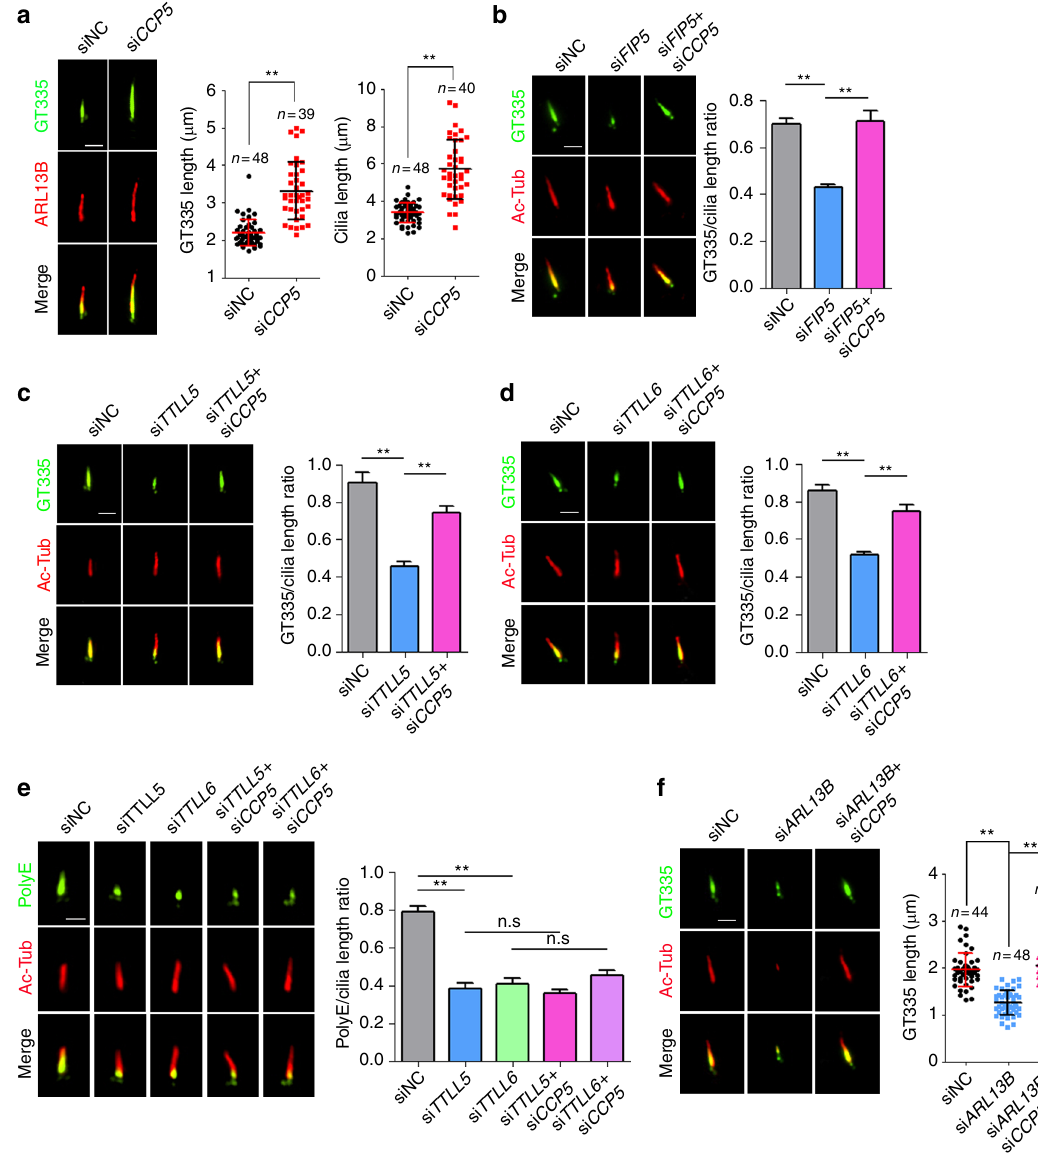
Fig. 4 A balanced enzymatic activity between CCP5 and TTLL5/TTLL6 is critical for maintaining a proper level of axoneme polyglutamylation. Axoneme polyglutamylation was detected by antibody GT335 or polyE. GT335 antibody detects all polyglutamate side chains independently of their length ( ≥ 1 glutamates) while polyE antibody is speci fi c to long side chains ( ≥ 3 glutamates). a Depletion of CCP5 increased axoneme polyglutamylation and cilia length. Quanti fi cation in right panels. b – d Depletion of CCP5 corrected FIP5 - ( b , siNC: n = 54, siFIP5: n = 42, siFIP5 + siCCP5: n = 49 cilia), TTLL5 - ( c , n = 50 cilia for each group), or TTLL6 - ( d , n = 50 cilia for each group) knockdown-induced defective axoneme polyglutamylation as detected by GT335 antibody. Quanti fi cation in right panels. e Depletion of CCP5 could not restore long-chain axoneme glutamylation as detected by polyE antibody. Quanti fi cation in right panel ( n = 50 cilia for each group). f Depletion of CCP5 restored axoneme polyglutamylation in ARL13B-de fi cient cells as detected by GT335 antibody. Quanti fi cation in right panel. Scale bars: 2 μ m. Center values represent mean. Error bars represent s.d. N values: cilia number accessed from at least six fi elds. Statistical signi fi cance was determined using unpaired Student ’ s t test. ** p <